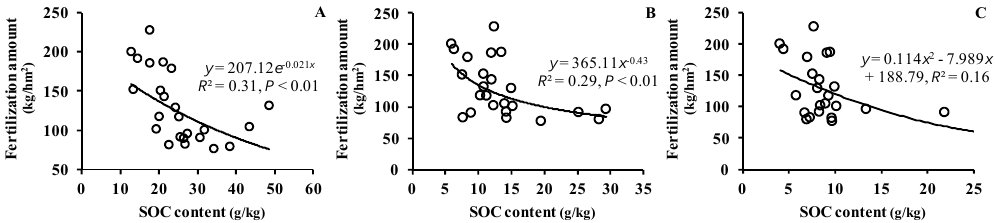
Figure 7. Correlations of cropland fertilization amount with SOC content in the Sanjiang Plain for different soil layers ( (a) : 0–30cm; (b) : 30–60cm; (c) :